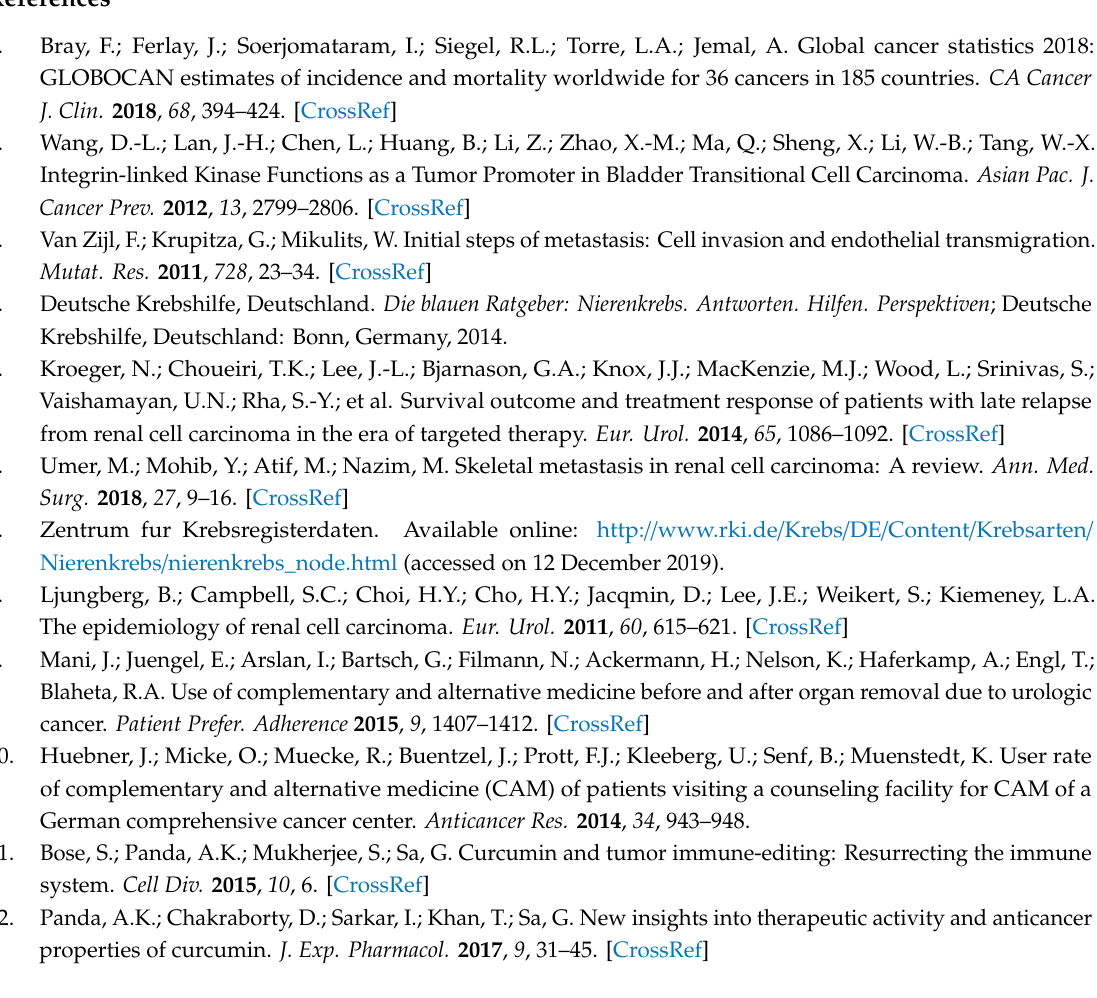
Figure S1: Whole western blots for Figure 7, Figure S2: Pixel density values for Figure